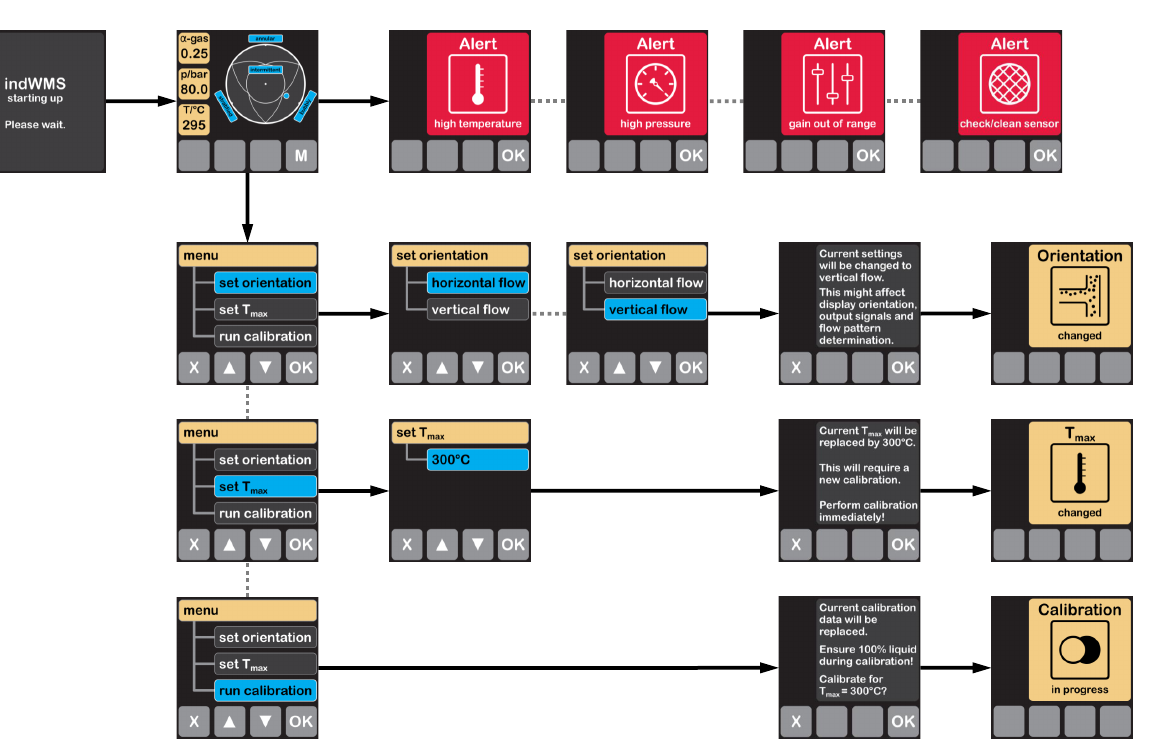
Figure 3. Display screens and menu structure of the